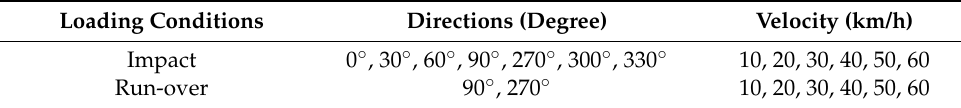
Table 2. The matrix of impact and run-over loading conditions.